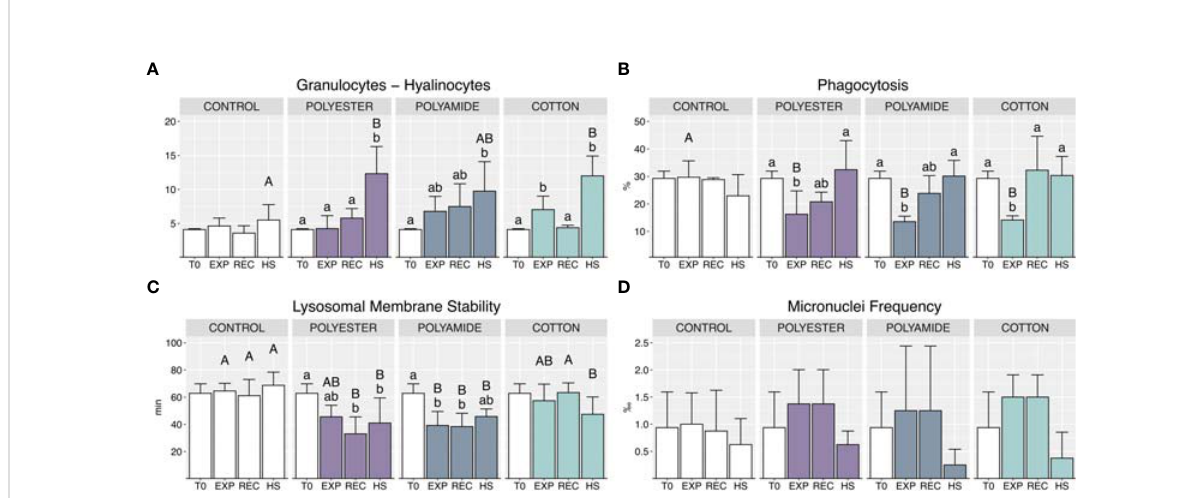
FIGURE 3 Haemocytes sub-populations and functional parameters: granulocytes – hyalinocytes ratio (A) , phagocytosis (B) , lysosomal membrane stability (C) , micronuclei frequency (D) in control and polyester, polyamide or cotton-exposed mussels measured at T0 and at the end of each experimental phase (EXP, end of MFs-exposure; REC, recovery after MFs-exposure; HS, heat-stress after the MFs-exposure). Upper case letters highlight differences among treatments within the same experimental phase; lower case letters highlight differences among different experimental phases of the same treatment. Values are given as mean ± SD